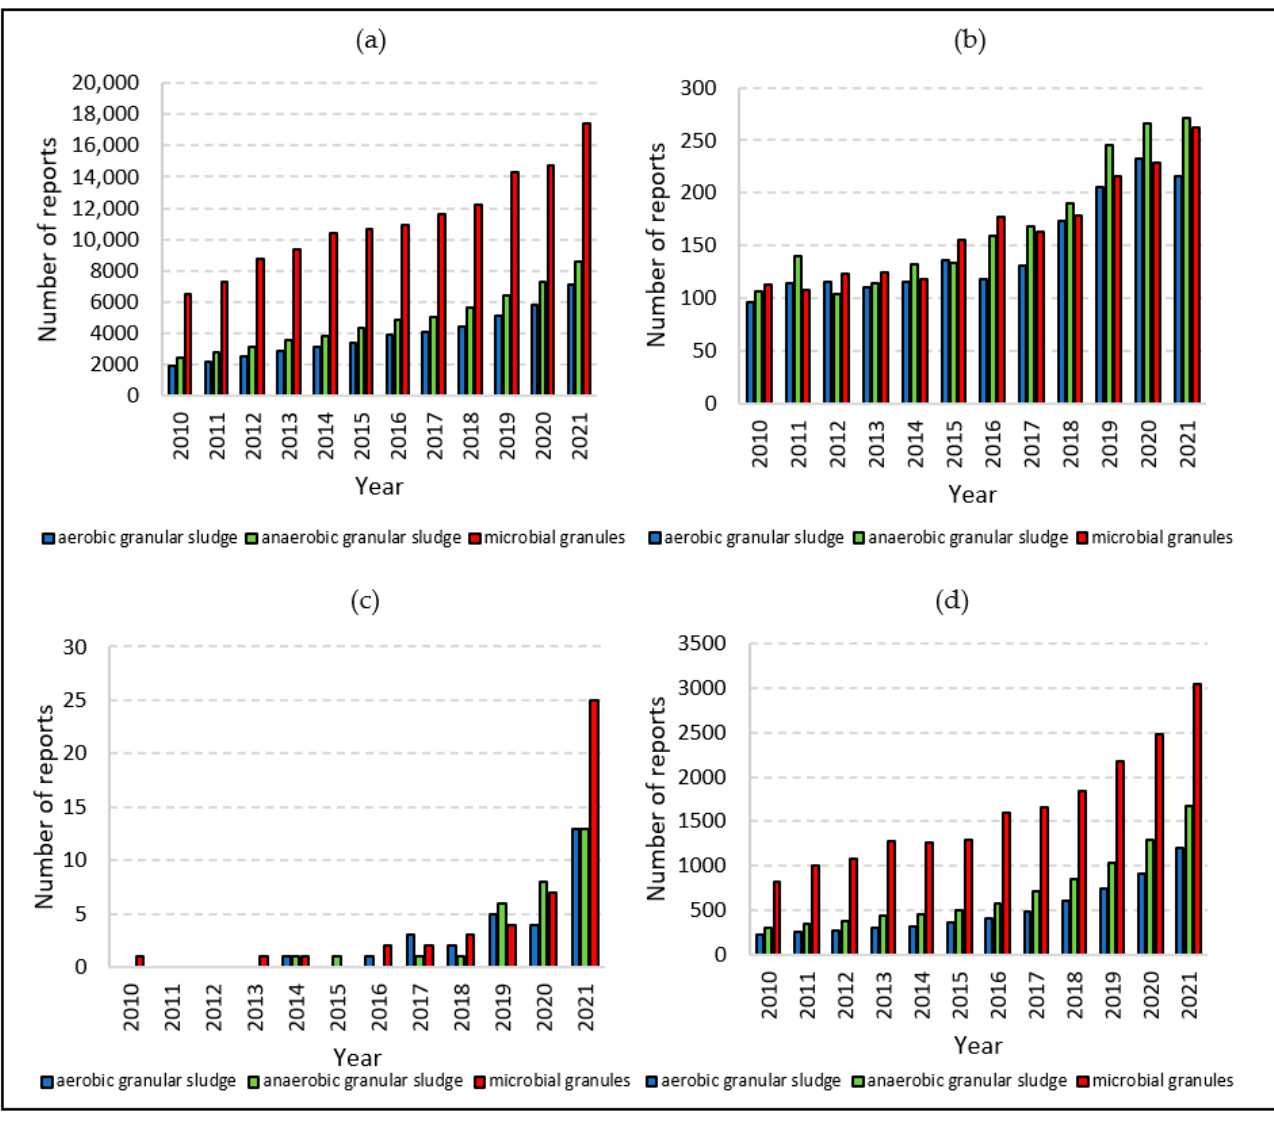
Figure 4. Number of articles found in ( a ) Google Scholar, ( b ) Scopus, ( c ) MDPI, and ( d ) Science Direct databases between 2010 and 2021 for the keywords “aerobic granular sludge”, “anaerobic granular sludge”, and “microbial granules”. Accessed 30 October